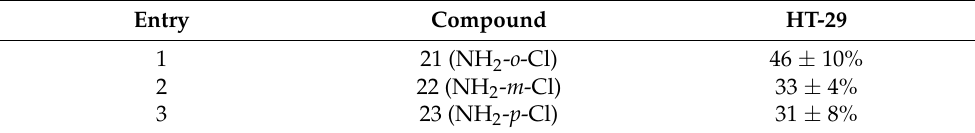
Table 6. Kinase activity for 21–23 measured in HT-29 cell cultures 1 .